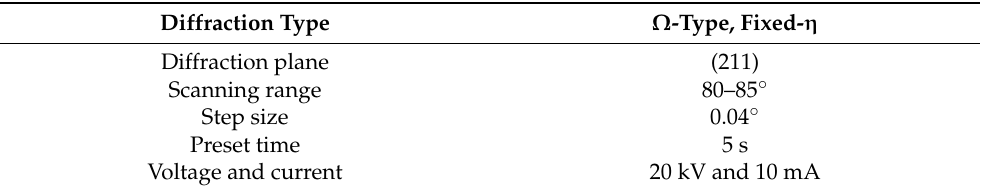
Table 5. XRD experimental conditions for JIS S50C